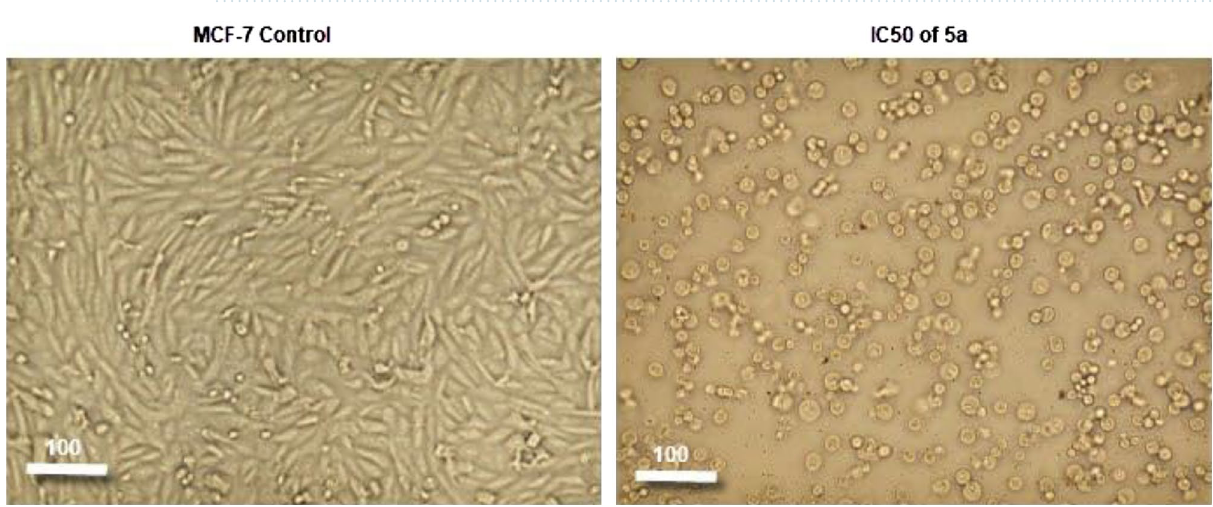
Figure 6. Morphological features of the cell death in MCF-7 cells treated with IC50 of the compound 5a after 48 h